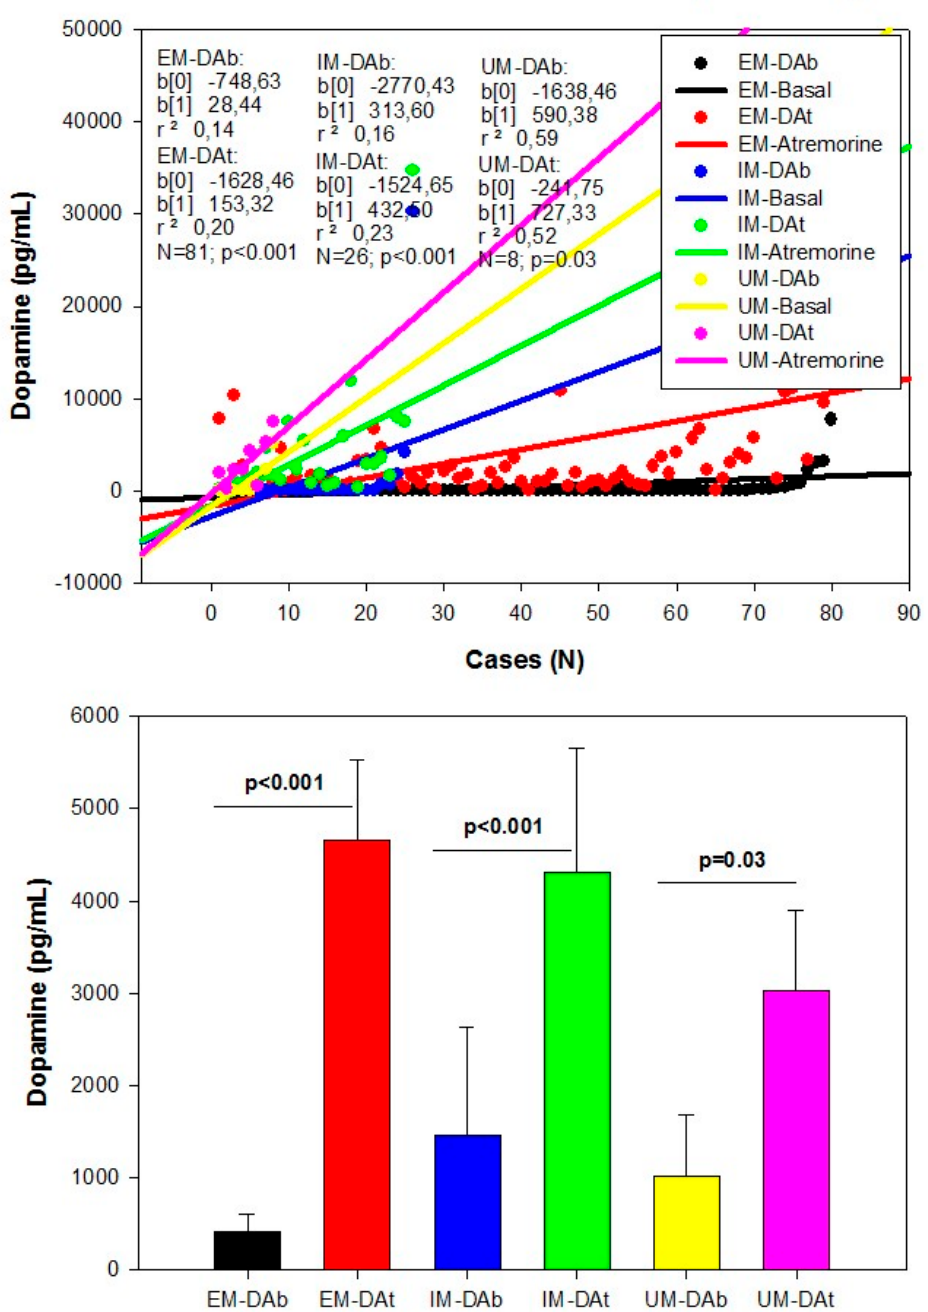
Figure 4. CYP2C19-related Atremorine-induced dopamine response. Basal (DAb) and Atremorine- induced dopamine response (DAt) in CYP2C19 extensive (EM), Intermediate (IM), and Ultra-rapid metabolizers (UM). Adapted with permission from Cacabelos et al. [17].